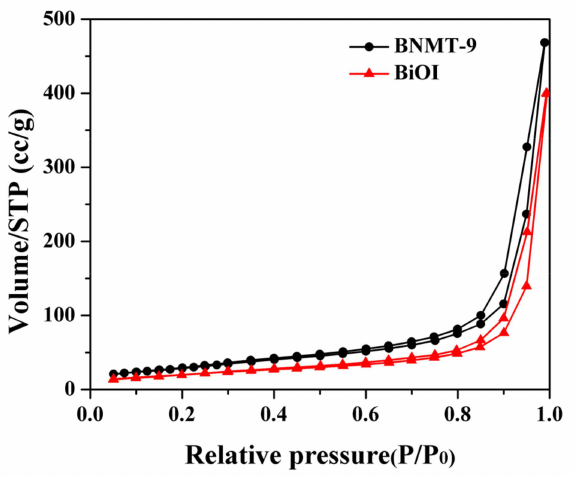
Figure 4. N 2 adsorption/desorption isotherms of BiOI and BNMT-9.